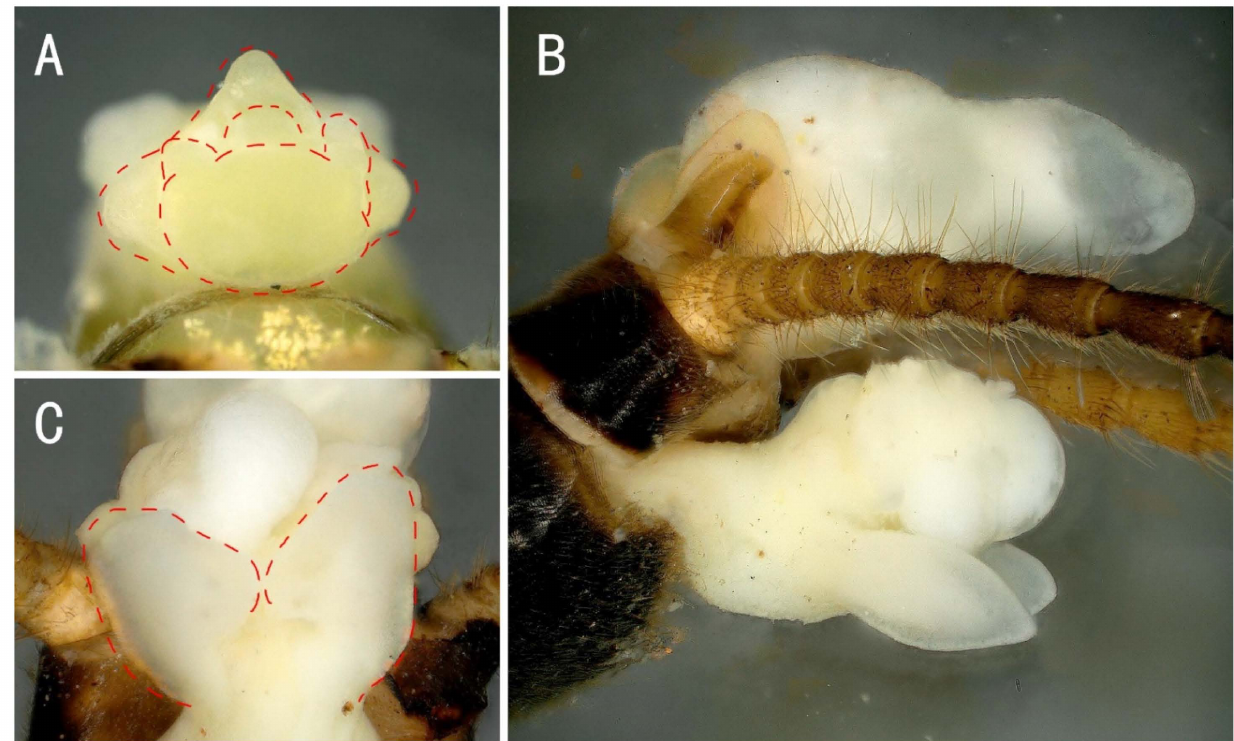
Figure 10. Filchneria zhouchangfai from Anhui, aedeagus. ( A ) top view; ( B ) lateral; ( C ) ventral. Nymphs: Mature nymphs are ca. 20 mm long (number = 9). Color of dorsal body is grey with some pale pattern; ventral body side is paler grey (Figure 11A). Body is